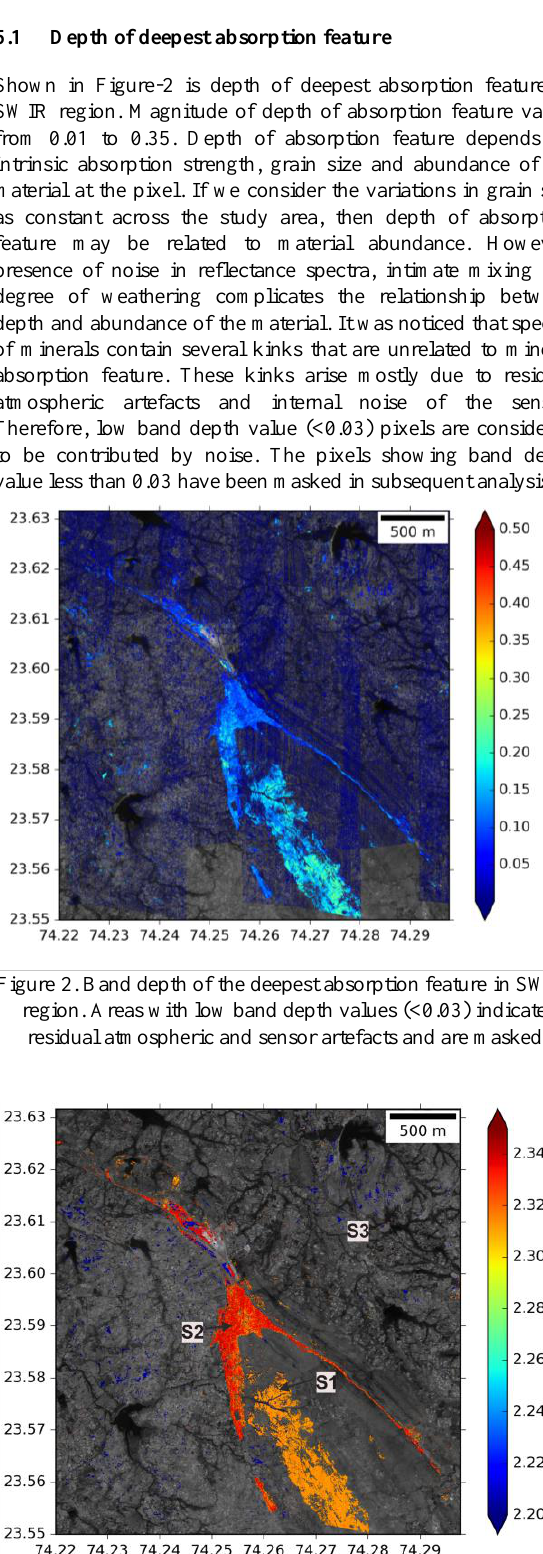
Figure 3. Wavelength of deepest absorption feature in SWIR regions. Regions in reddish brown, orange and bluish